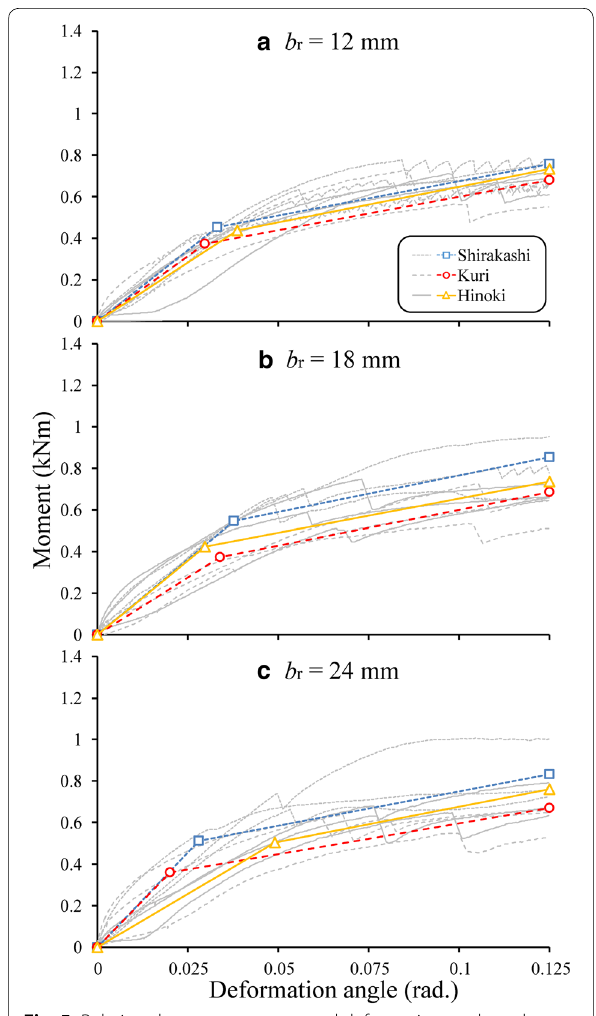
Fig. 5 Relations between moment and deformation angle and bilinear showing the average of characteristic (Rs series) [5]. See Fig. 3